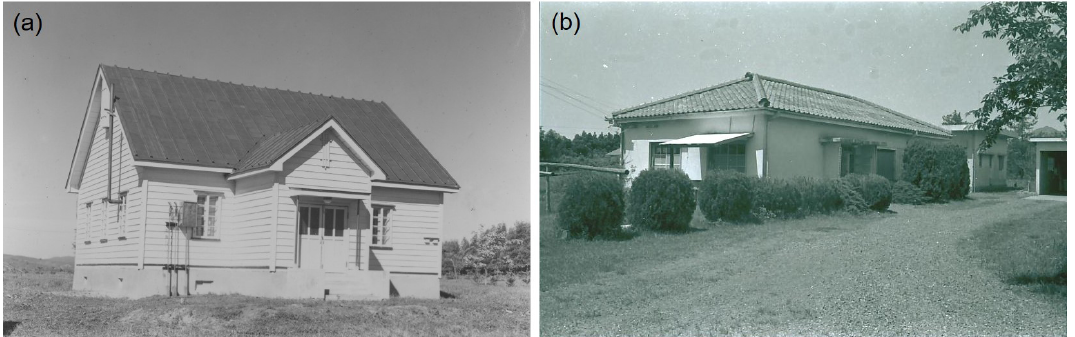
Figure 17. (a) The absolute measurement house of Memambetsu Magnetic Observatory in 1952. (b) The main office at Kanoya Magnetic Observatory in 1969 (photo supplied by Kakioka Magnetic